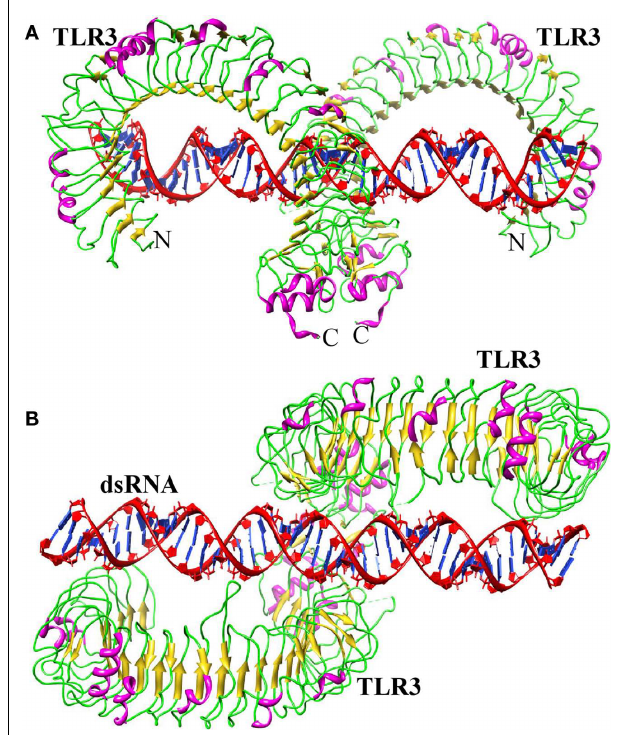
FIGURE 3 | Structure ofTLR3–dsRNA. (A) Ribbon structure ofTLR3 dimer (colored according to the secondary structure: helix-pink; sheet-yellow; loop-green) bound with dsRNA (red). (B) Top